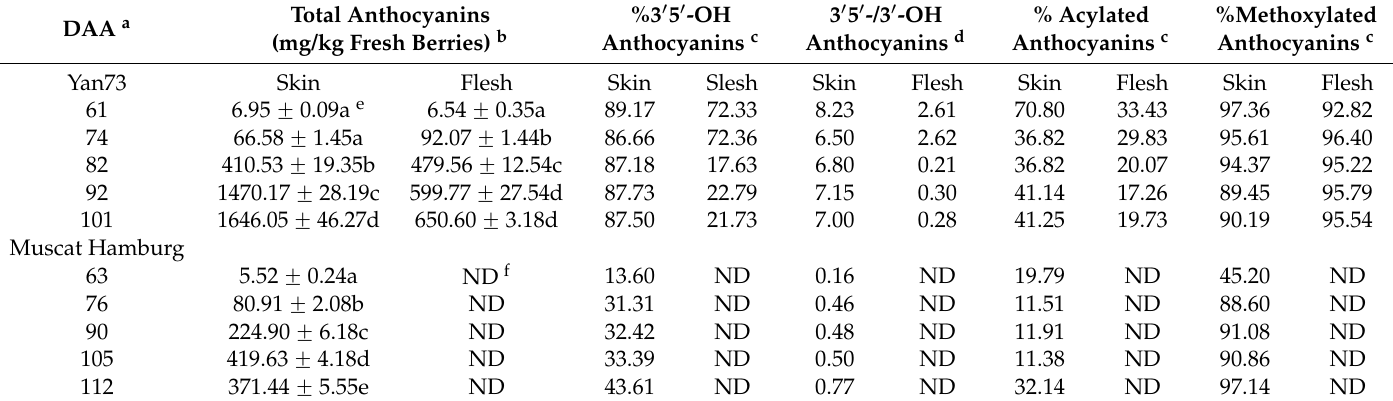
Table 1. Anthocyanin profiles of the skin and flesh tissues of Yan73 and Muscat Hamburg across 5 developmental stages. Total Anthocyanins %3 1 5 1 -OH 3 1 5 1 -/3 1 -OH % Acylated %Methoxylated DAA a (mg/kg Fresh Berries) b Anthocyanins c Anthocyanins c Anthocyanins c Yan73 Skin Flesh Skin Slesh Skin Flesh Skin Flesh Skin Flesh